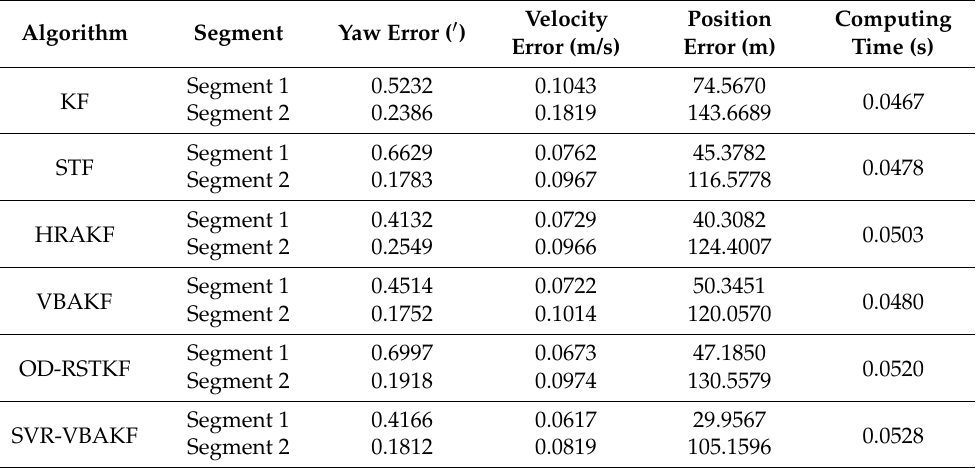
Table 6. Mean square errors of yaw, velocity, position and single step running time of each group of data under different